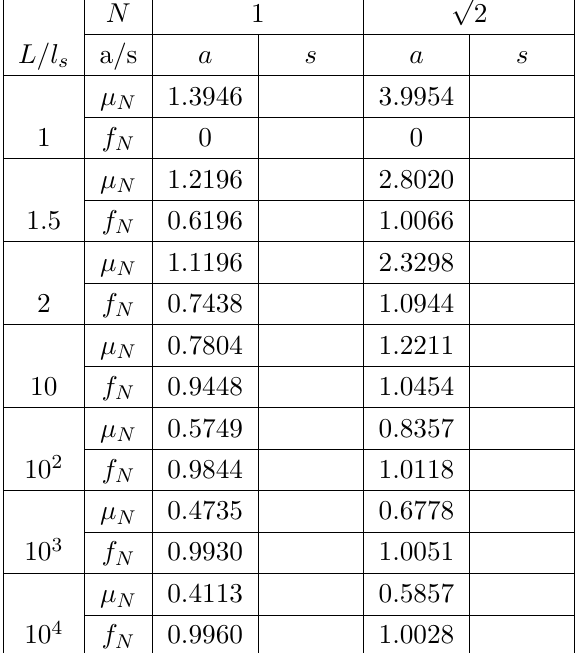
Table 2. The (cid:12)rst modes of the Kaluza-Klein spectrum for d = 2, in terms of their deviation f N (4.20) from the standard spectrum. An empty cell means that the mode has not been found within the search